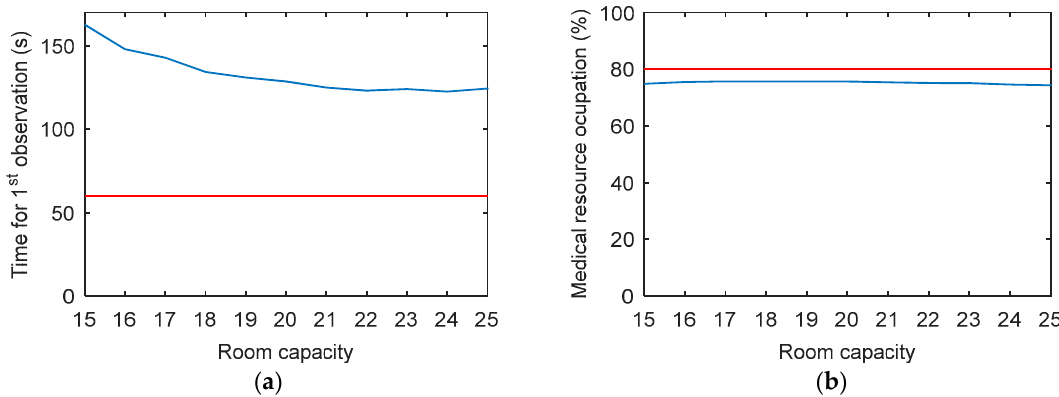
Figure 14. Obtained values for different capacity scenario: ( a ) waiting time for first medical intervention (blue line — simulation model, red line — Manchester time); ( b ) medical resource occupation (blue line — simulation model, red line — occupation rate limit).